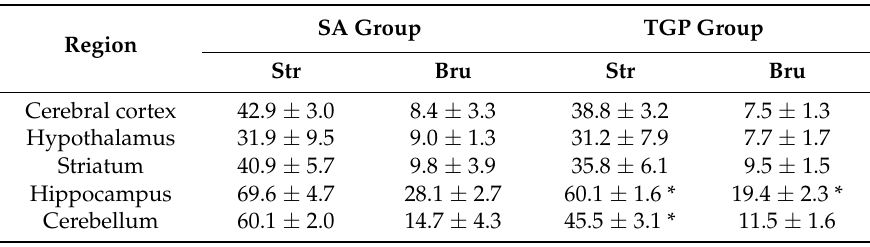
Table 4. Contents of Str and Bru in different brain regions (ng/g).